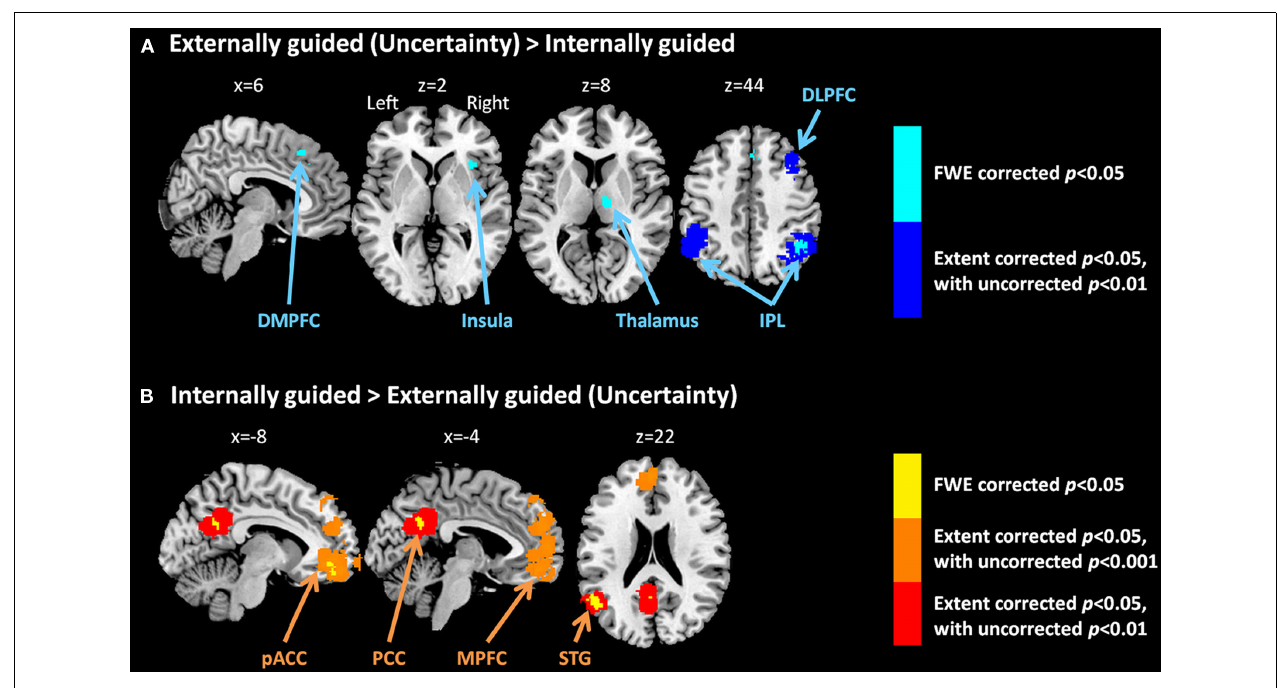
uncorrected p < 0.001; blue, violet, and red, a medium threshold of FWE corrected for spatial extent at p < 0.05 with primary thresholds of uncorrected p < 0.01. No cluster was observed at the stringent threshold in externally guided decision-making under uncertainty > internally guided decision-making. DMPFC, dorsomedial prefrontal cortex; DLPFC, dorsolateral prefrontal cortex; IPL, inferior parietal lobule; pACC, perigenual